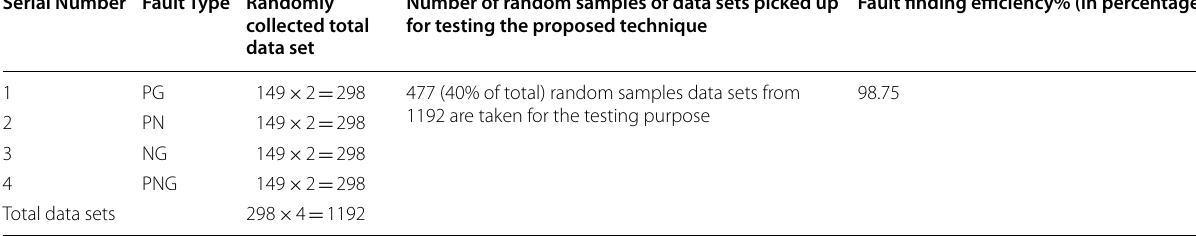
Table 9 Calculated efficiency of the proposed method Serial Number Fault Type Randomly collected